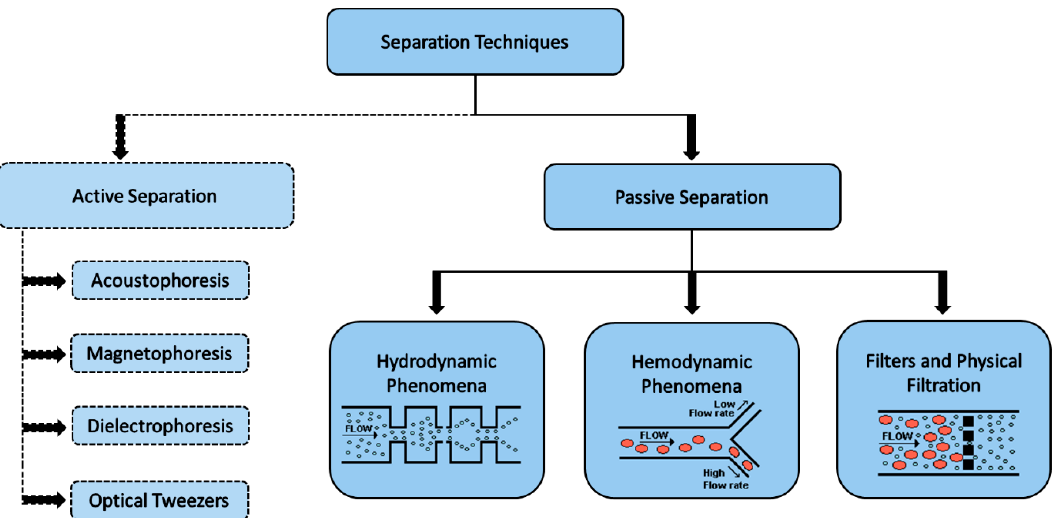
Figure 5. Classification of the main active and passive separation techniques used in microfluidic systems.